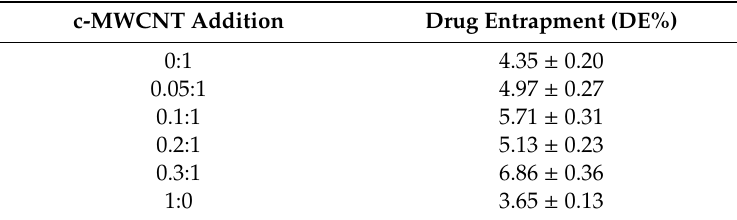
Table 3. Drug entrapment (DE%) of drug-loaded MPEG-PDLLA / c-MWCNT nanocomposites prepared from the MPEG-PDLLA / c-MWCNTs mixed solutions with di ff erent c-MWCNT (tube diameter > 30 nm, length 0.5~2 µ m) additions.